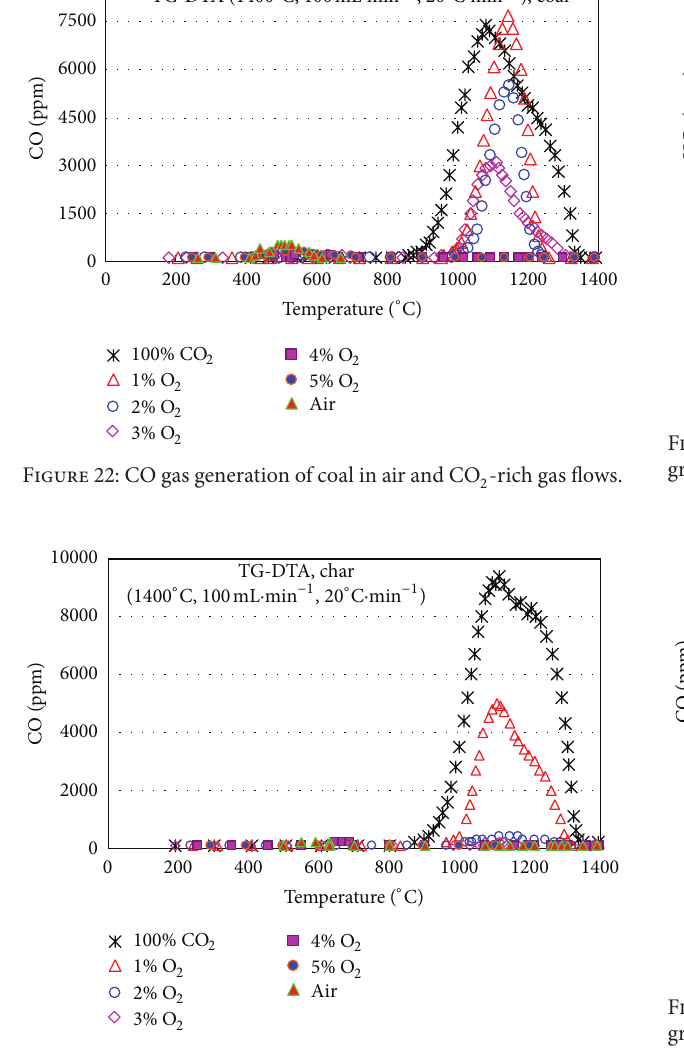
Figure 23: CO gas generation of char in air and CO 2 -rich gas flows.